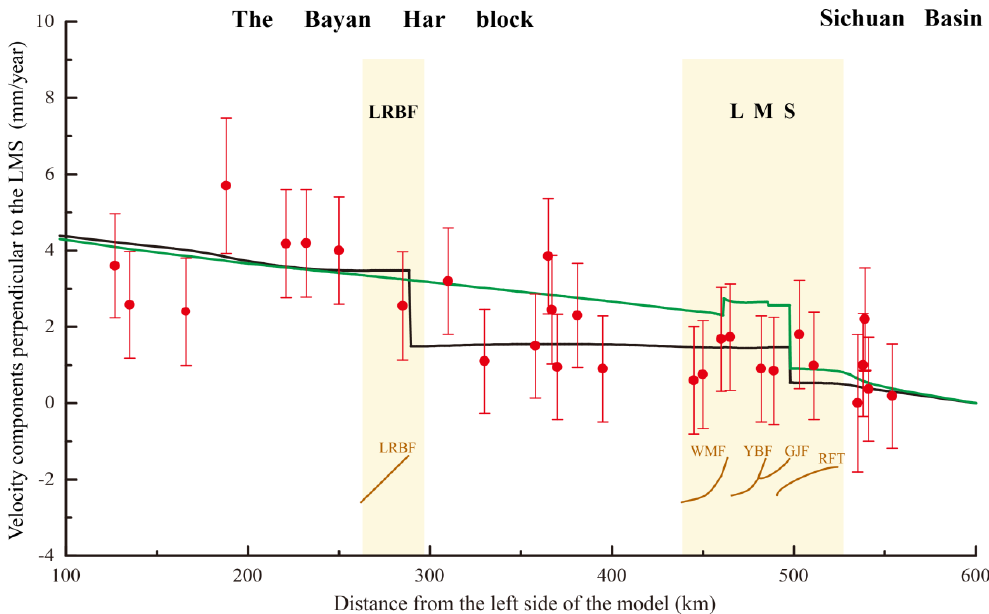
Figure 3. Comparison of simulated horizontal velocity results with GPS velocity component perpendicular to the LMS. Black line: Simulation results with LRBF in Model 4; Green line: Simulation results without LRBF in Model 4; Red points: GPS velocity component (Zhang et al. [39]); Yellow areas: The Longriba fault and the Longmen Shan thrust belt; Grey lines: Faults in the models.